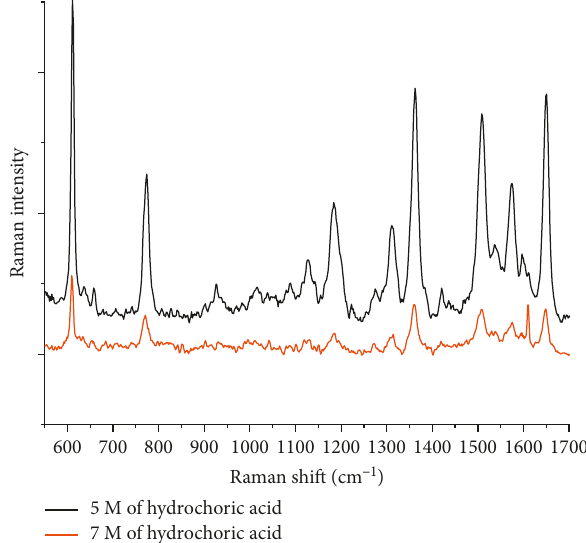
Figure 3: Raman spectra for samples b and c dyed by 10